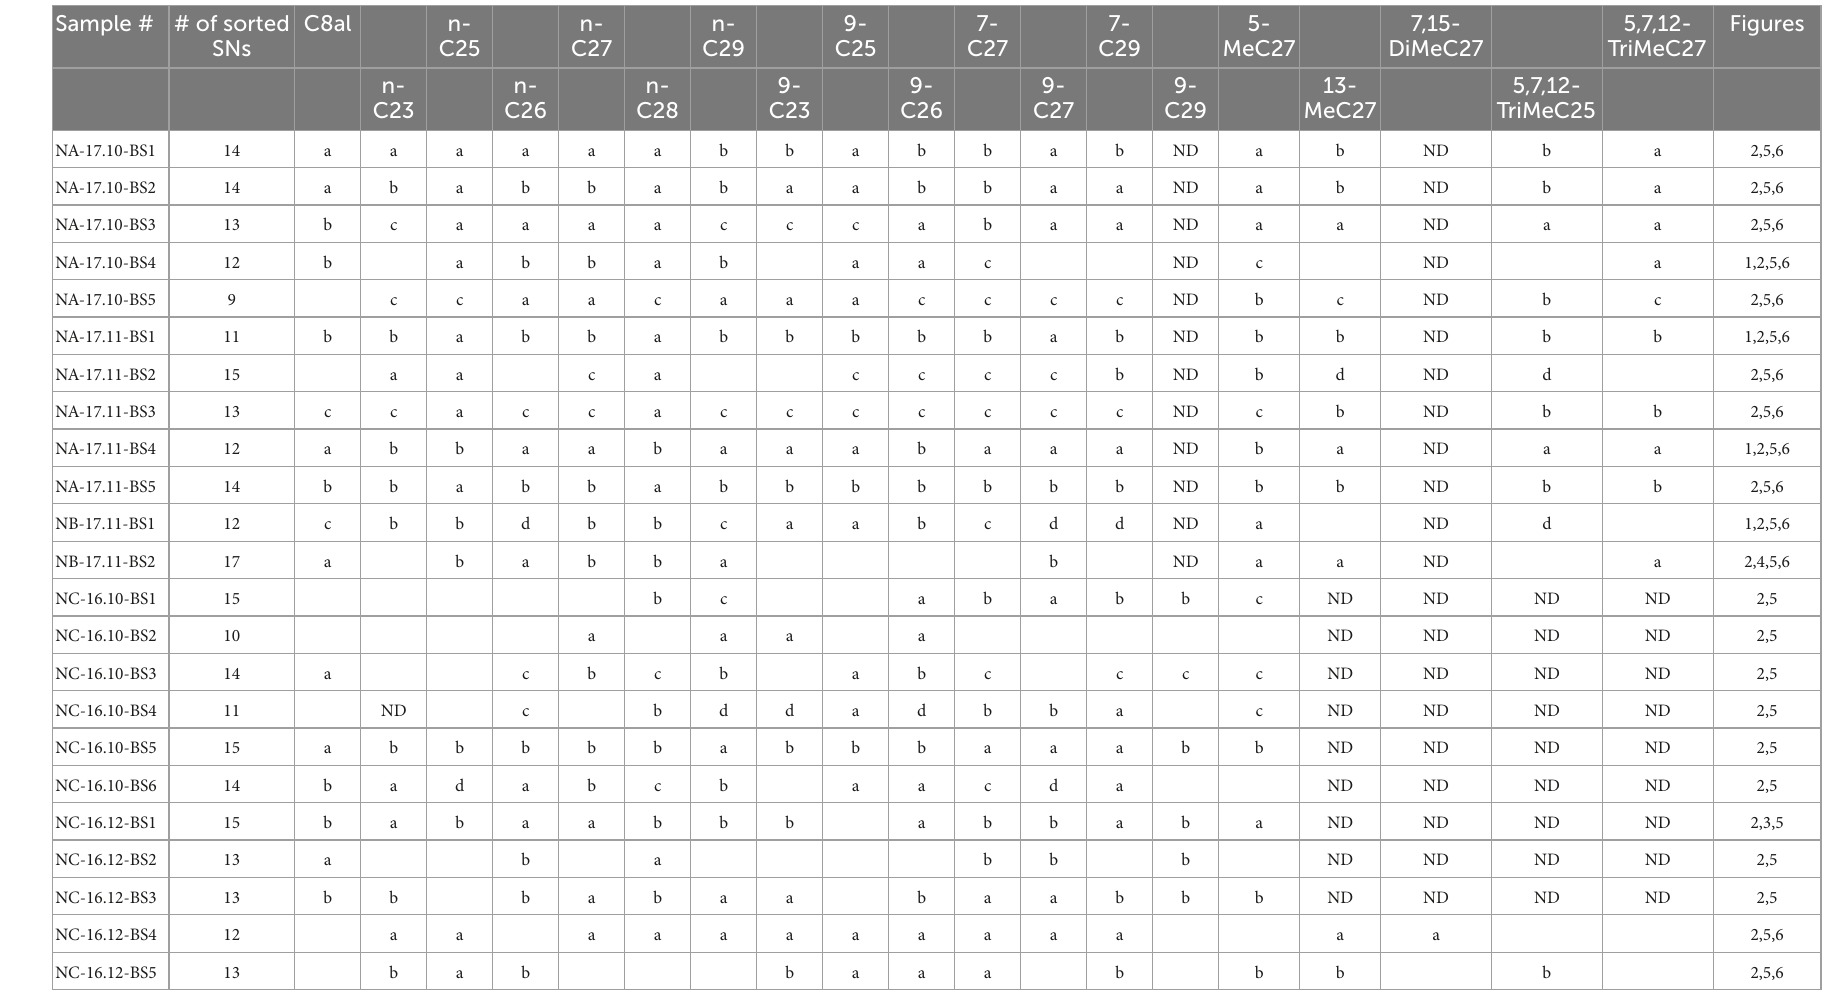
TABLE 2 Results of spike sorting and cluster analysis of CHCs in each of 23 basiconic sensilla. Sample # # of sorted